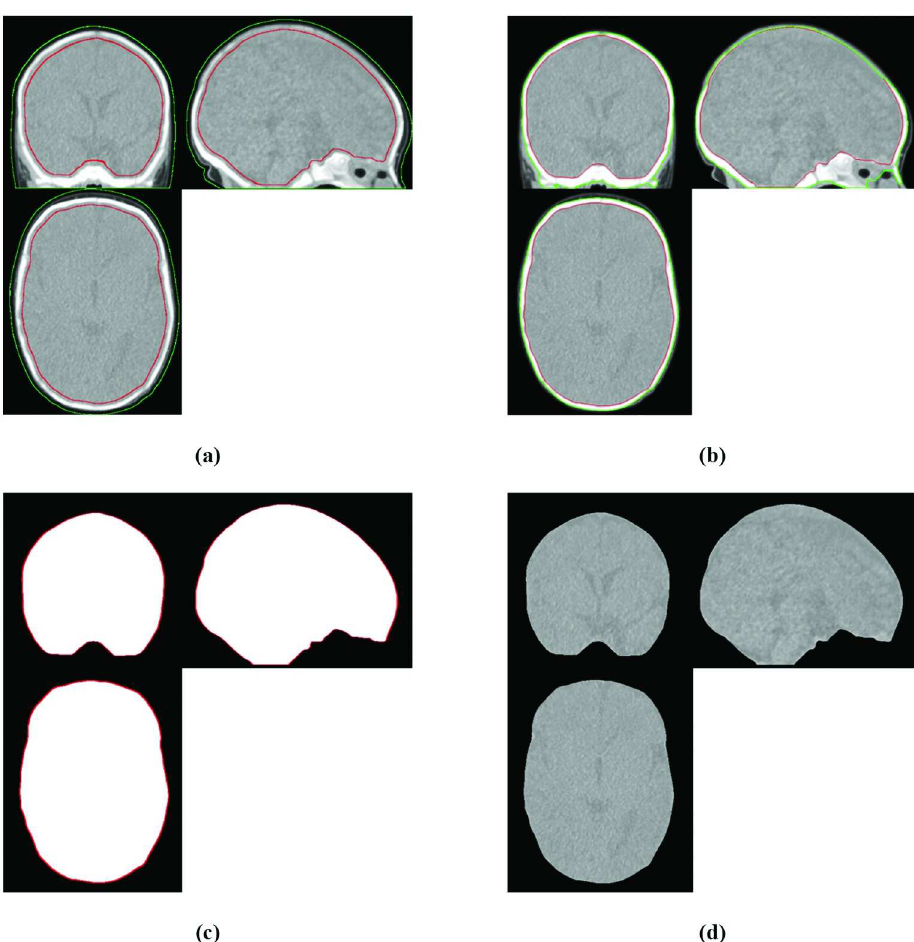
Fig 4. CT intracranial extraction using coupled level sets. (a) The initial coupledlevel sets. (b) The extracted inner and outer surfaces of cranial bones and fontanels-sutures using the method describedin [46]. (c) Corresponding mask of the resultinginterior contour. (c) The extracted intracranialCT image obtainedby multiplyingthe mask to the preprocessed CT image. The interior and exterior contours are represented by the red and green colour,